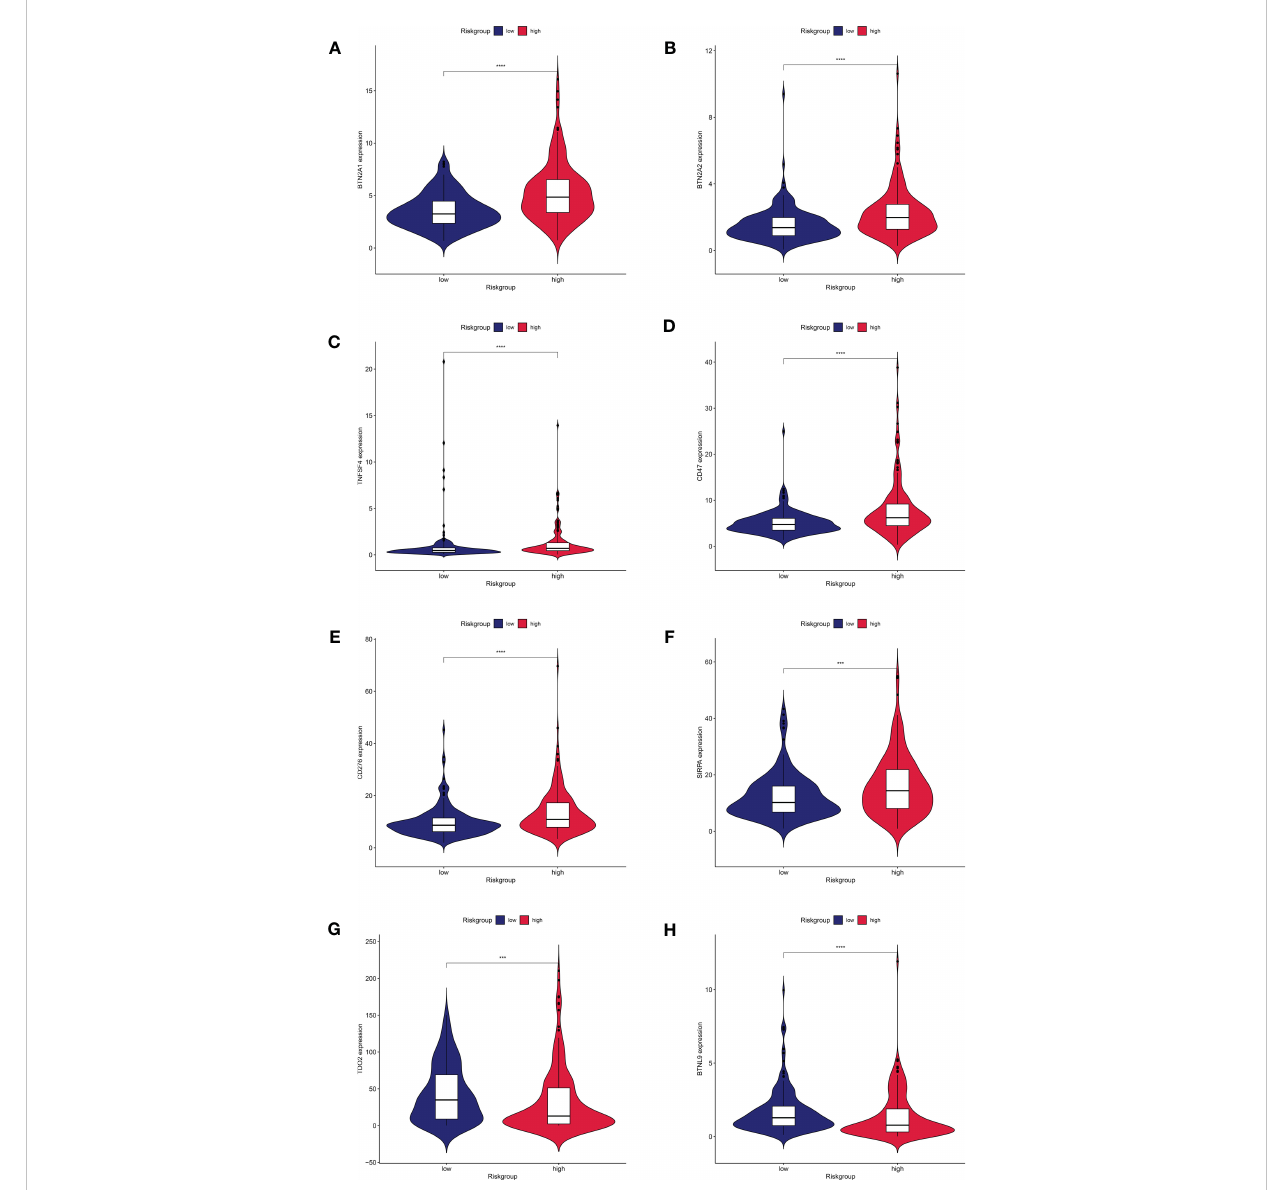
FIGURE 7 Expression of immune checkpoint genes between high and low risk groups.8 immune checkpoint genes were signi fi cantly different in high- and low risk- groups. The expression of (A) BTN2A1, (B) BTN2A2, (C) TNFSF4, (D) CD47, (E) CD276, (F) SIRPA, (G) TDO2, and (H) BTNL9 showed signi fi cant differences in the high and low risk